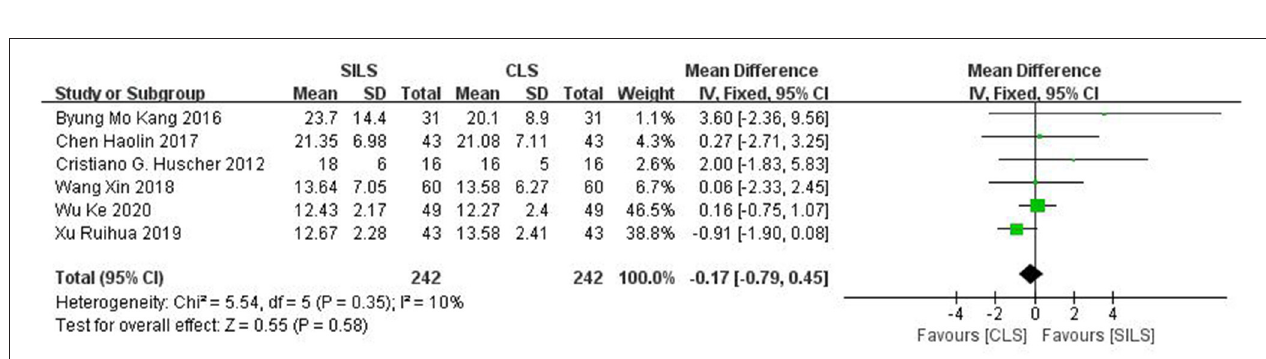
FIGURE 5 | Meta-analysis of intraoperative blood loss. SILS, single-incision laparoscopic surgery; CLS, conventional laparoscopic surgery.